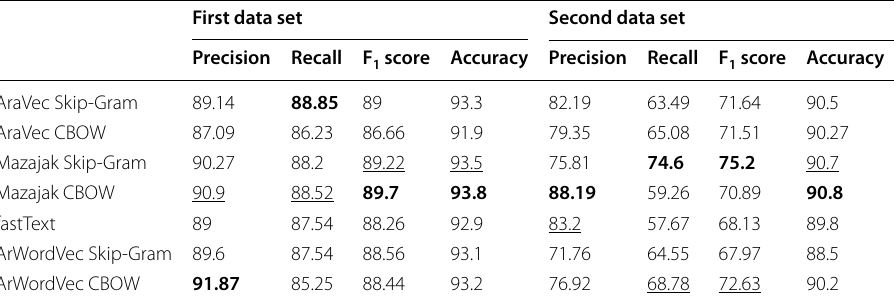
Table 7 Results of BLSTM using different pre-trained word embeddings on the first and second data